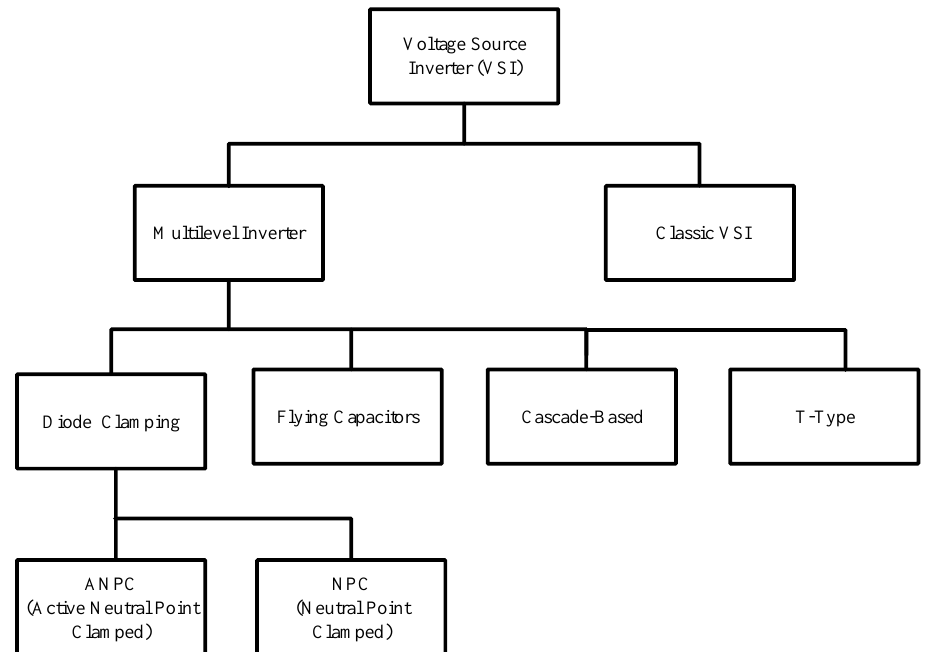
Figure 1. Voltage source DC-AC inverter classification.